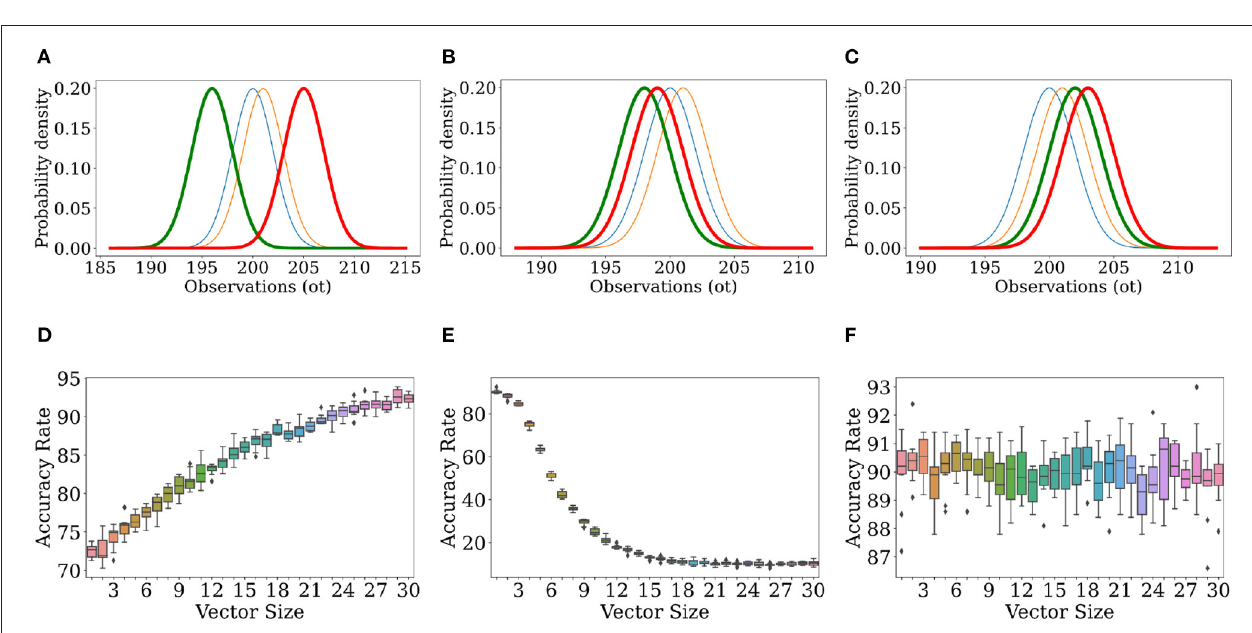
ρ r ρ f N(200, 2), N(201, 2)] and prior probability f of ˜ = ˜ = 0.9 for the trial whose results are shown in (B) . =